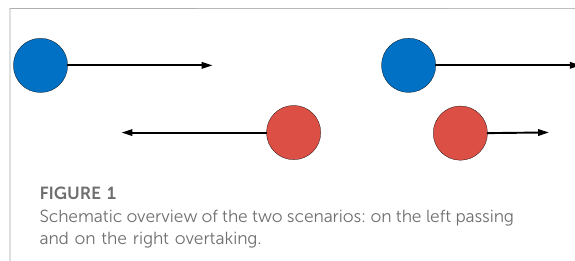
FIGURE 1 Schematic overview of the two scenarios: on the left passing and on the right